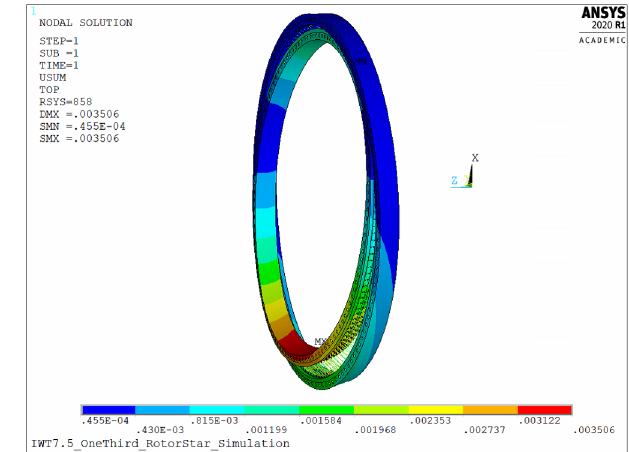
Figure 2. Bearing ring deformation in meters for the load case